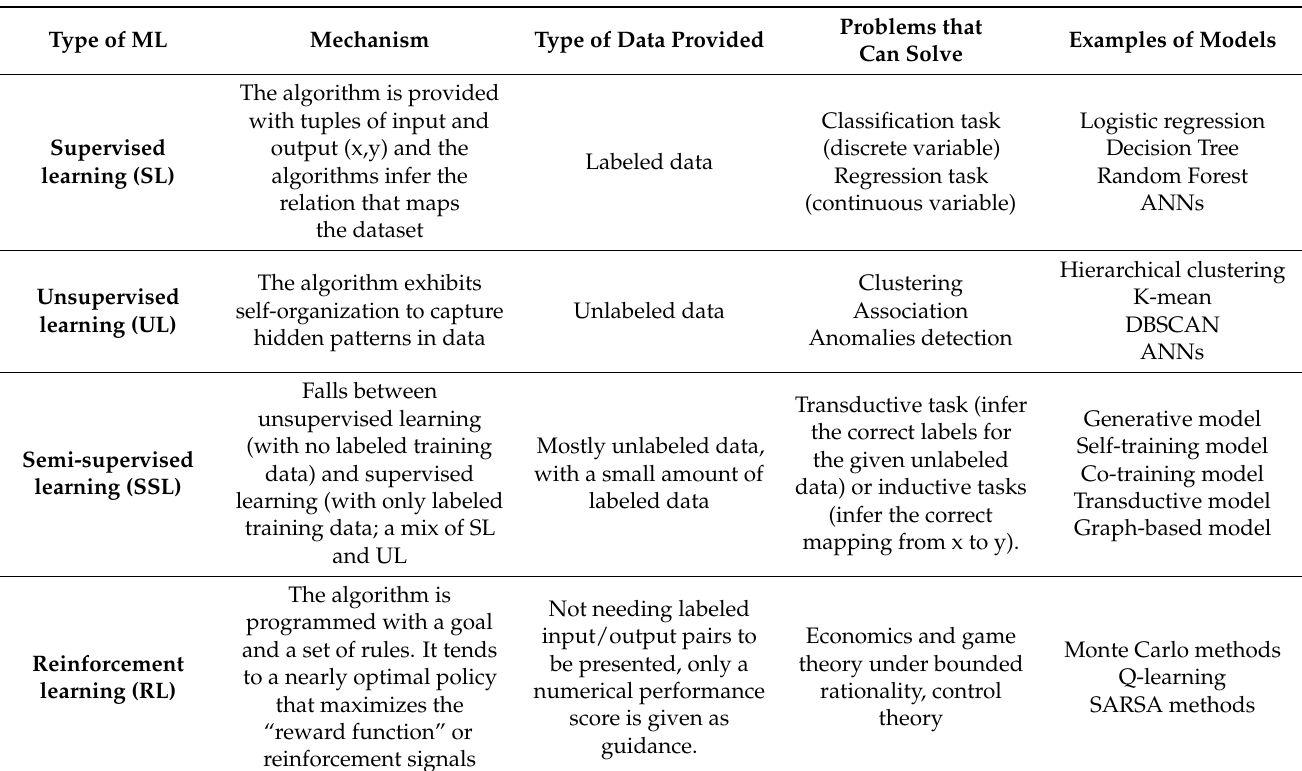
Table 1. The table describes the different types of ML, the mechanism on which they are based, some examples of possible applications, as well as some operating models for each type [13,14,16,17]. ANNs = artificial neural networks, DBSCAN = density-based spatial clustering of applications with noise, SARSA =